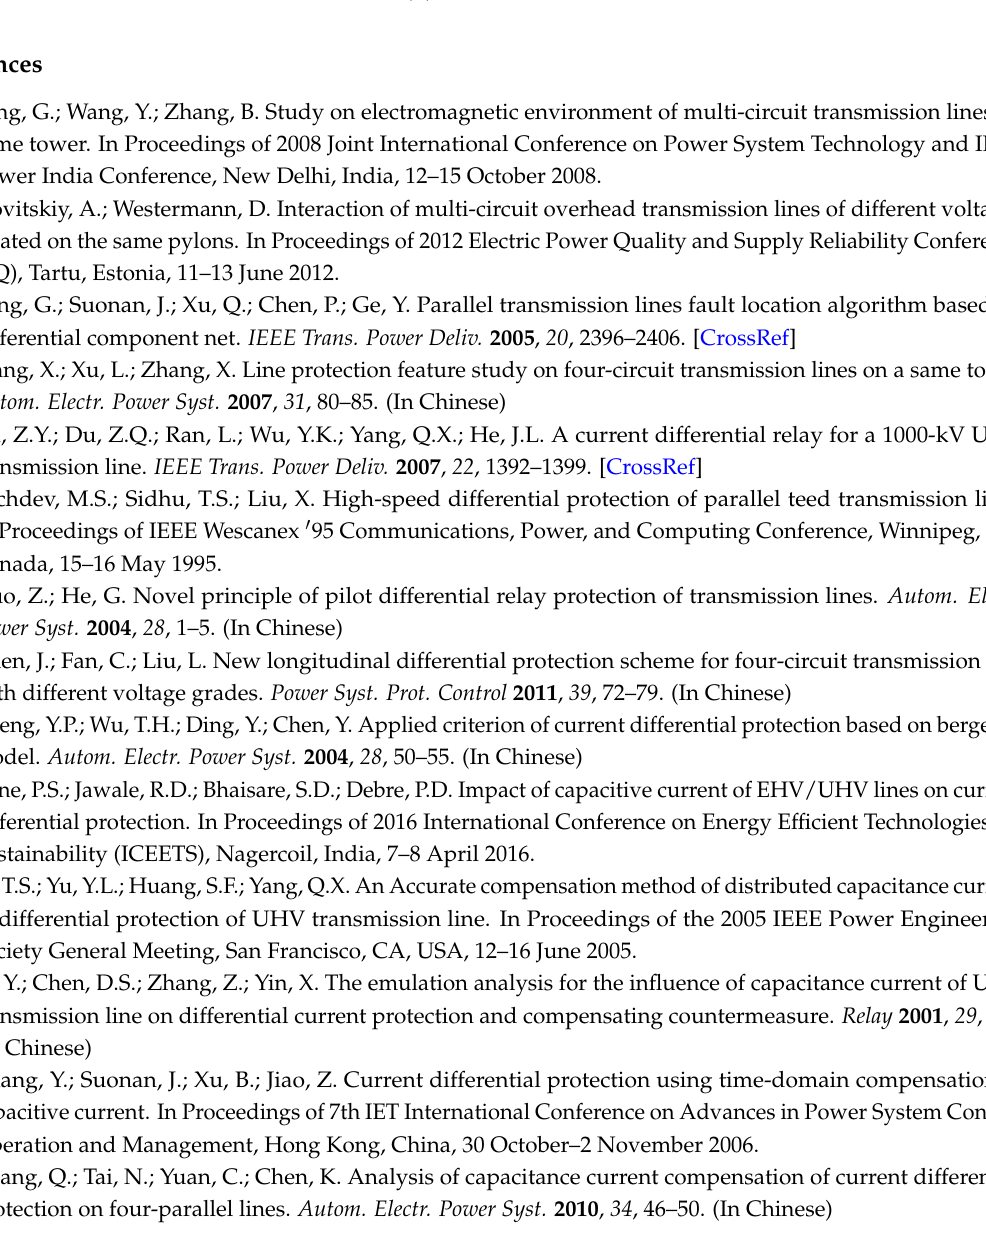
Figure B2. Arrangement of conductors of double-circuit lines on the same tower: ( a ) 500 kV double-circuit lines on the same tower; and ( b ) 220 kV double-circuit lines on the same tower.